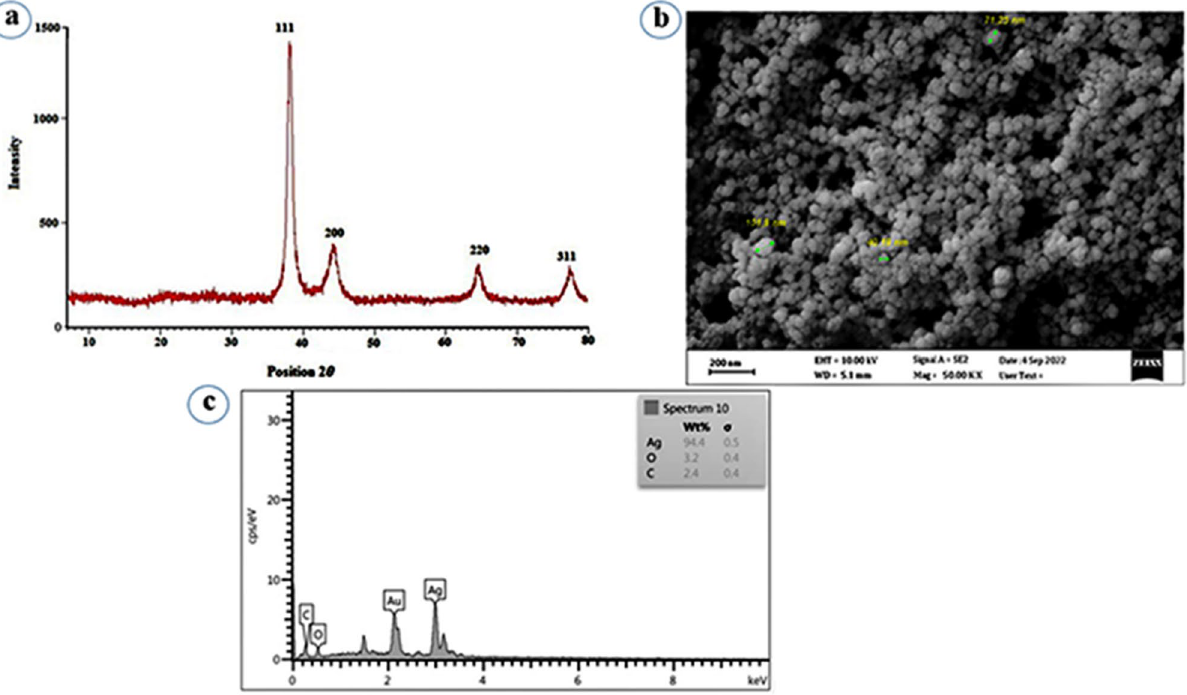
Figure 2. ( a ) XRD spectrum, ( b ) FESEM micrograph, ( c ) EDX spectrum of